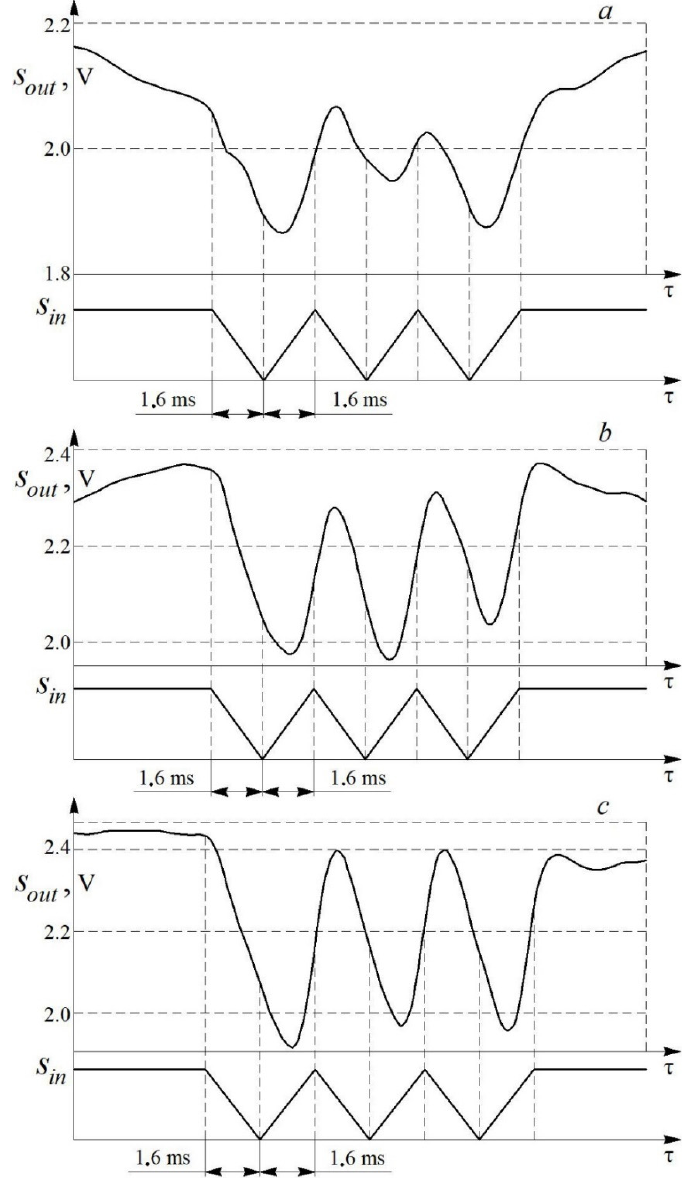
Figure 13. Comparison of the input S in and output S out signals of the measuring system during calibration by the method of paired pulses at different air flow velocities w : ( a )—15 m/s; ( b )—28 m/s; ( c )—40 m/s.